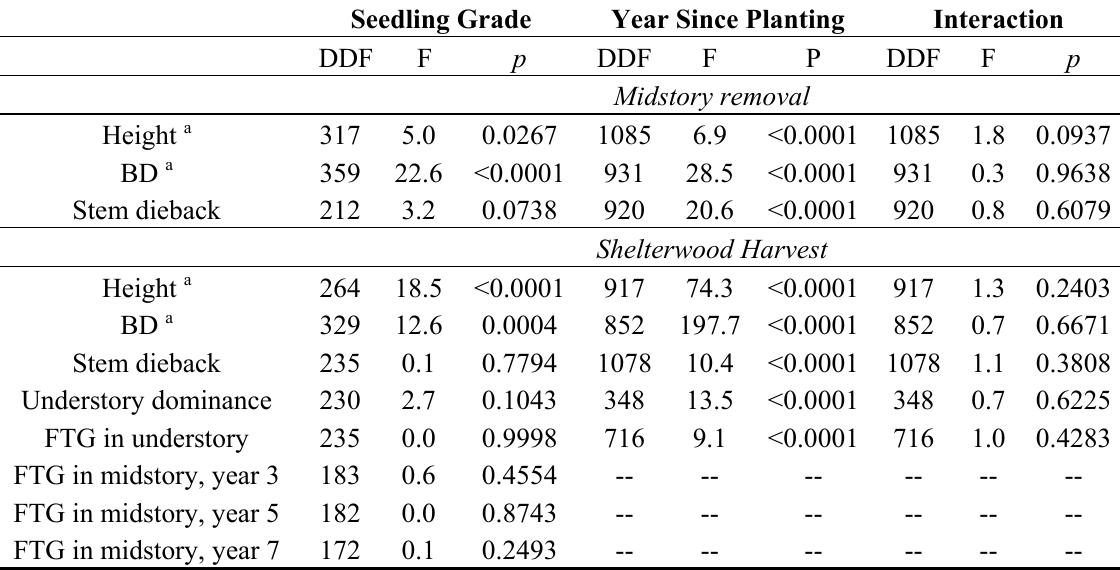
Table 3. General linear mixed models (height, basal diameter (BD)) or generalized linear mixed model (stem dieback, understory dominance, free-to-grow (FTG)) results at the midstory removal and shelterwood harvest stands where northern red oak was planted. GLMs were conducted separately by year for free-to-grow status in the midstory due to lack of convergence when year was included as a repeated measure.